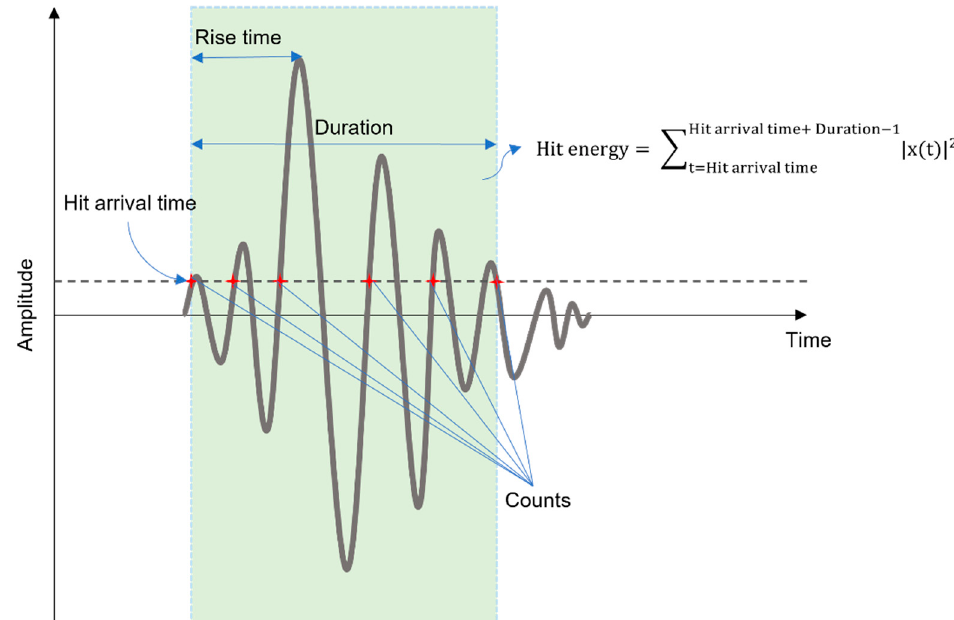
Figure 5. AE hit